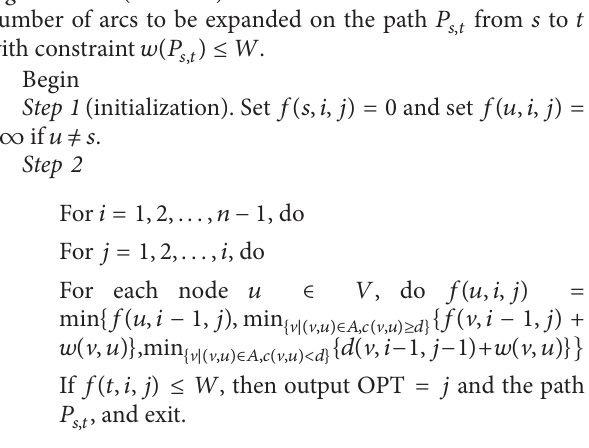
Algorithm 4 (MNCEP). Comment. Return the